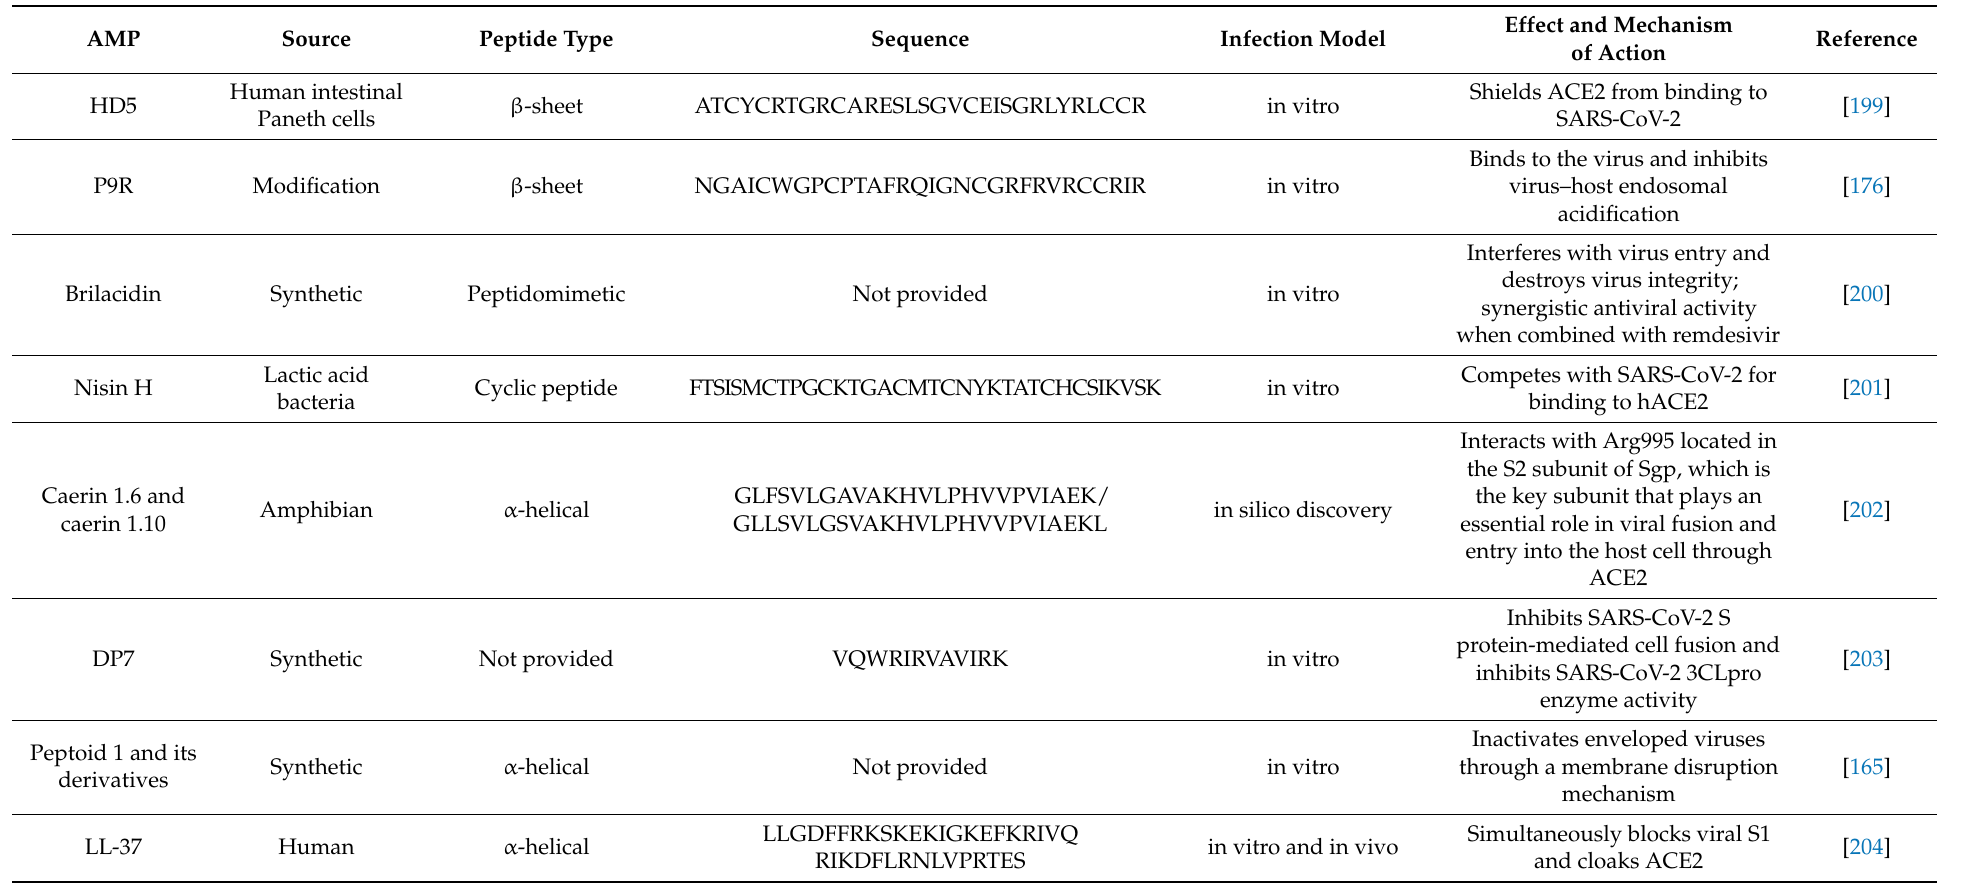
Table 1. Potential antiviral peptides against SARS-CoV-2 and their mechanisms of